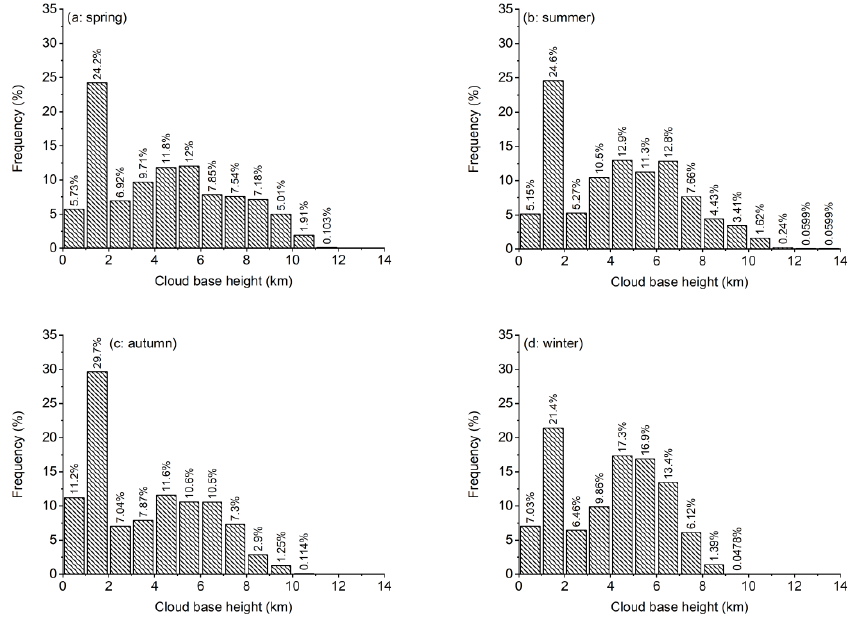
Figure 6. Frequency distributions of the cloud base height in ( a ) spring, ( b ) summer, ( c ) autumn and ( d ) winter.